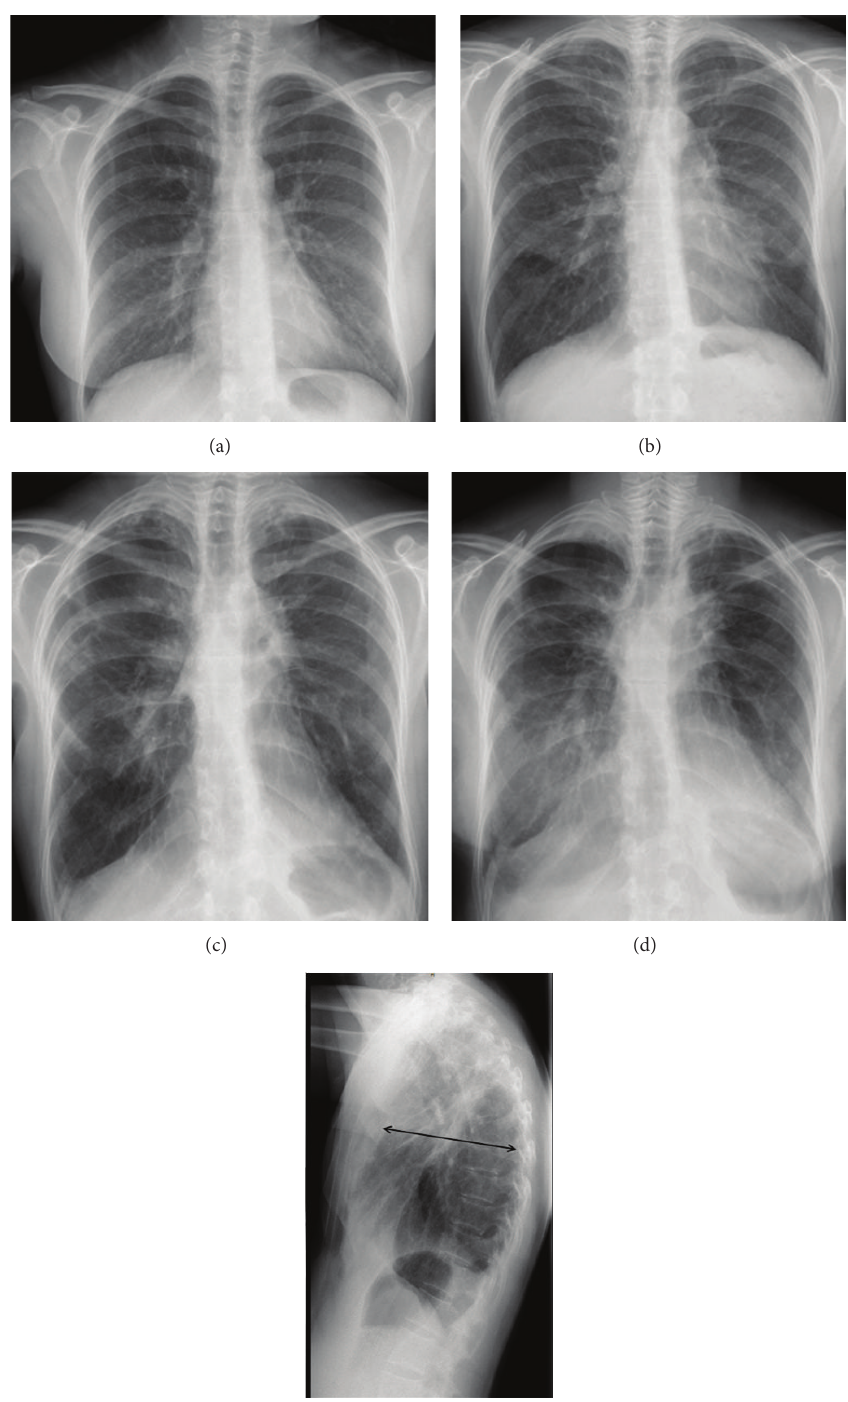
Figure 5: Case 2. (a) Initial chest radiograph after the diagnosis of breast cancer and before chemotherapy and radiotherapy treatment was normal.(b),(c),and(d)Chestradiographsevolutionalongtwo-yearandtwo-monthintervalrevealprogressiveworsening.Noticeprogressive gradual loss of lung volume at the expense of the upper lobes, which is manifested by superior shrinkage and distortion of the pulmonary hila, as well as biapical pleural thickening. (e) Lateral chest radiograph shows flattening of the chest, observed by the decreased anteroposterior diameter of the rib cage